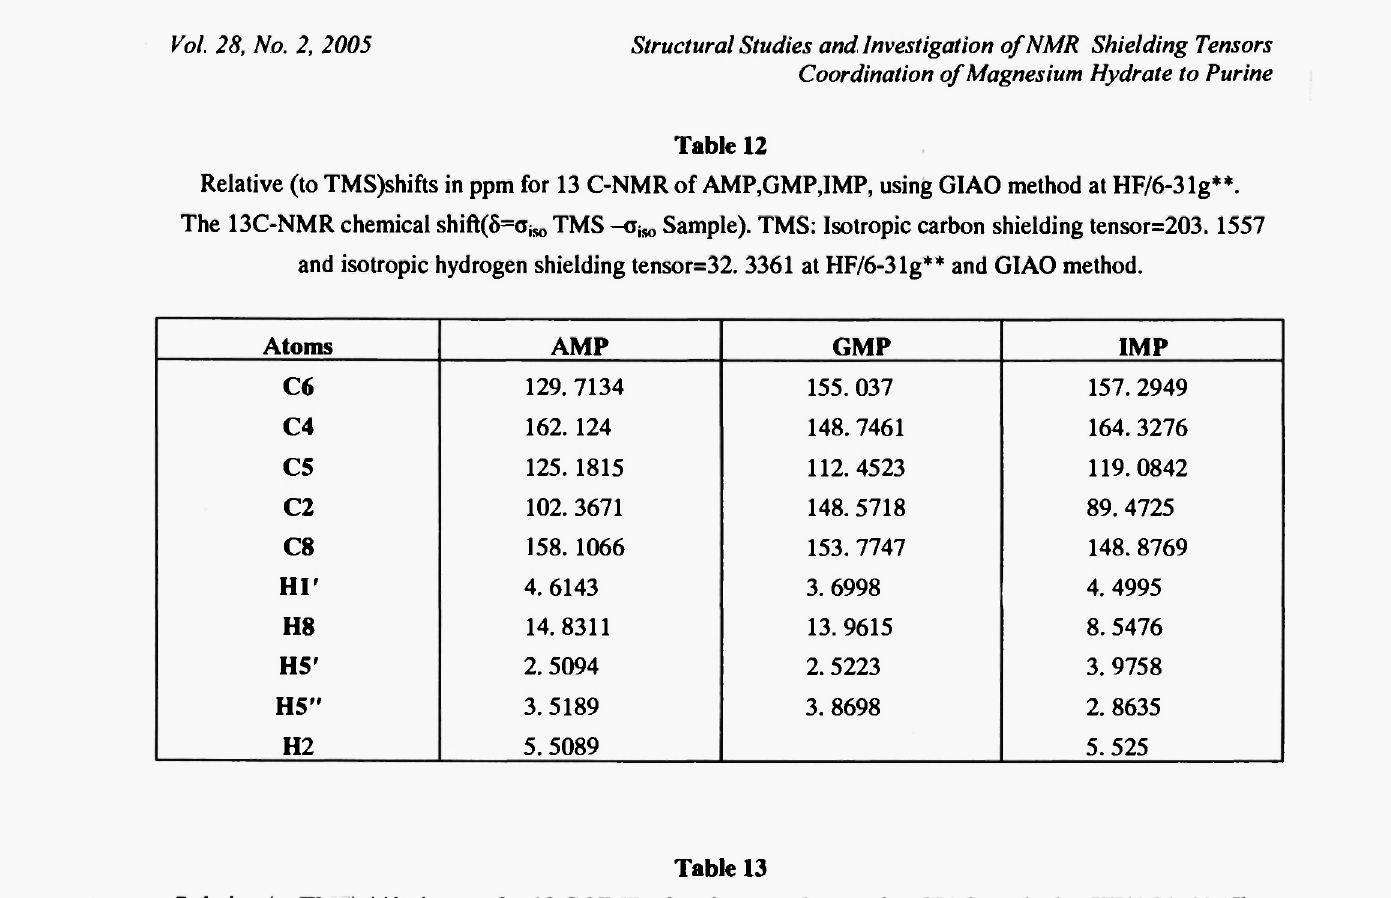
Relative (to TMS)shifts in ppm for 13 C-NMR of purine complexes using GIAO method at HF/6-31g**.